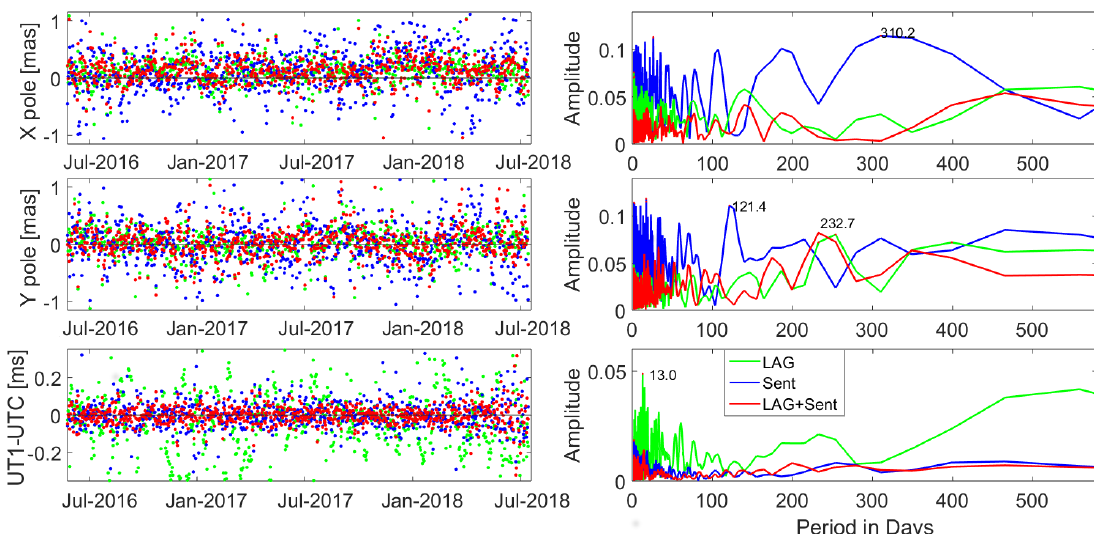
Figure 12. Differences of pole coordinates and UT1-UTC w.r.t. IERS-14-C04 series and the spectral analysis of differences for LAG (green), Sent (blue), and LAG+Sent (red)